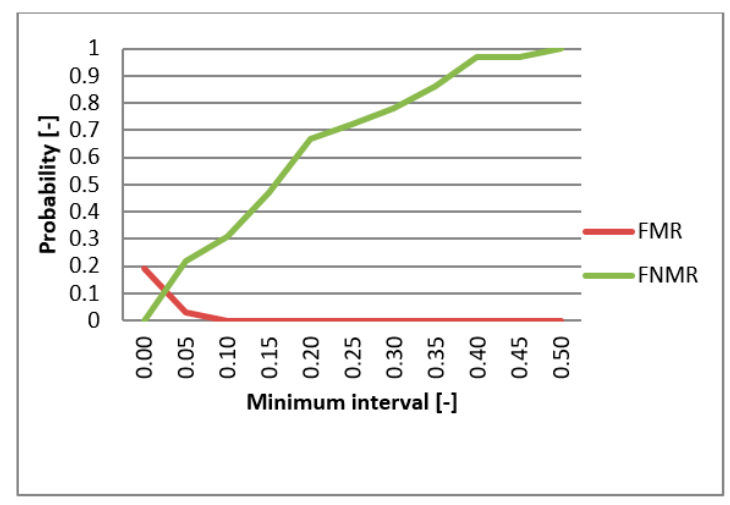
Figure 17 . EER for MHV. Figure 17. EER for